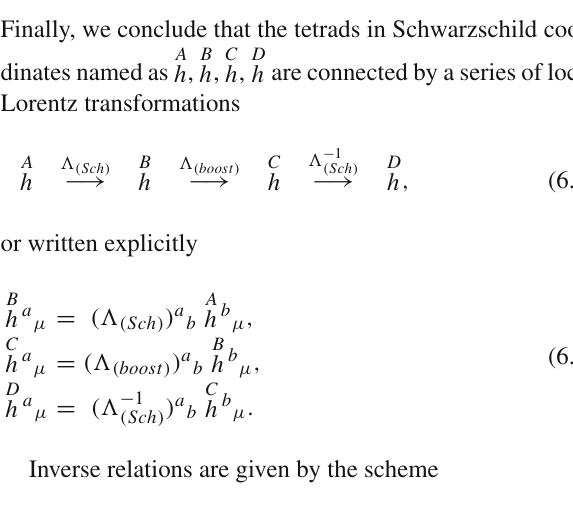
connection in the Schwarzschild static gauge, i.e. (4.3) and (4.5), and transforming simultaneously both variables we can obtain different representations of the Schwarzschild static gauge. We can schematically represent this as in the Fig. 1, where the dots represent the tetrads and arrows mean the Lorentz rotations applied to both the tetrad and the spin con- nection, the bold dot represents the initial tetrad in which we “switch off”